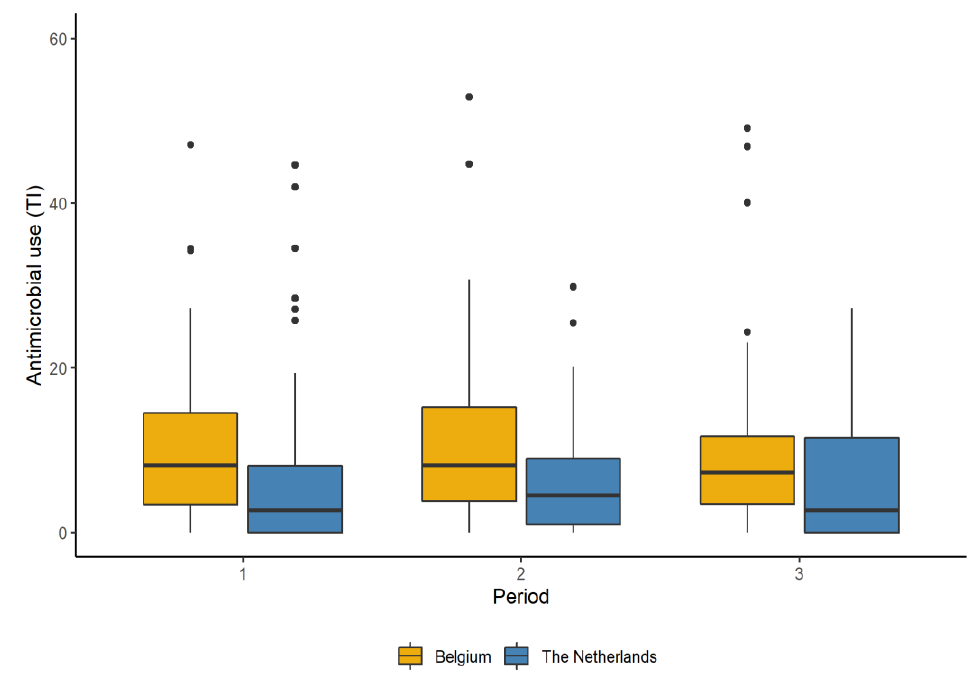
Figure 2. Antimicrobial use per coaching period for the participating broiler farms in Belgium ( n = 15) and the Netherlands ( n = 13). Antimicrobial use is expressed as the number of days an animal was treated with antimicrobials out of 100 days (treatment incidence (TI) per 100 days). The line within each box represents the median value. The lower and upper boundaries of each box correspond to the 25th and 75th percentiles, respectively. Whiskers below and above each box are the 10th and 90th percentiles. Points below and above the whiskers represent outliers.